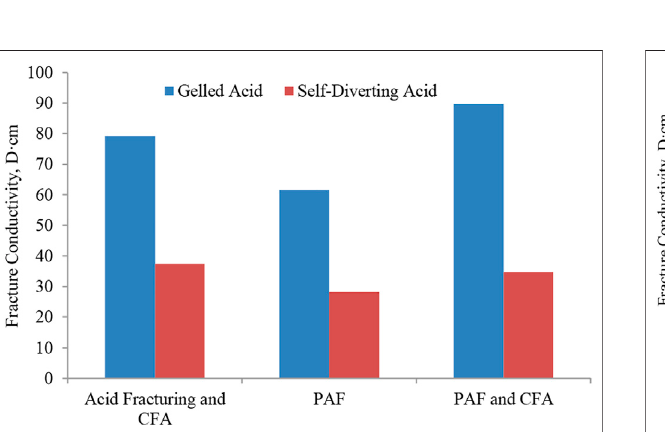
FIGURE 8 | Effect of the acid fracturing technique on long-term fracture